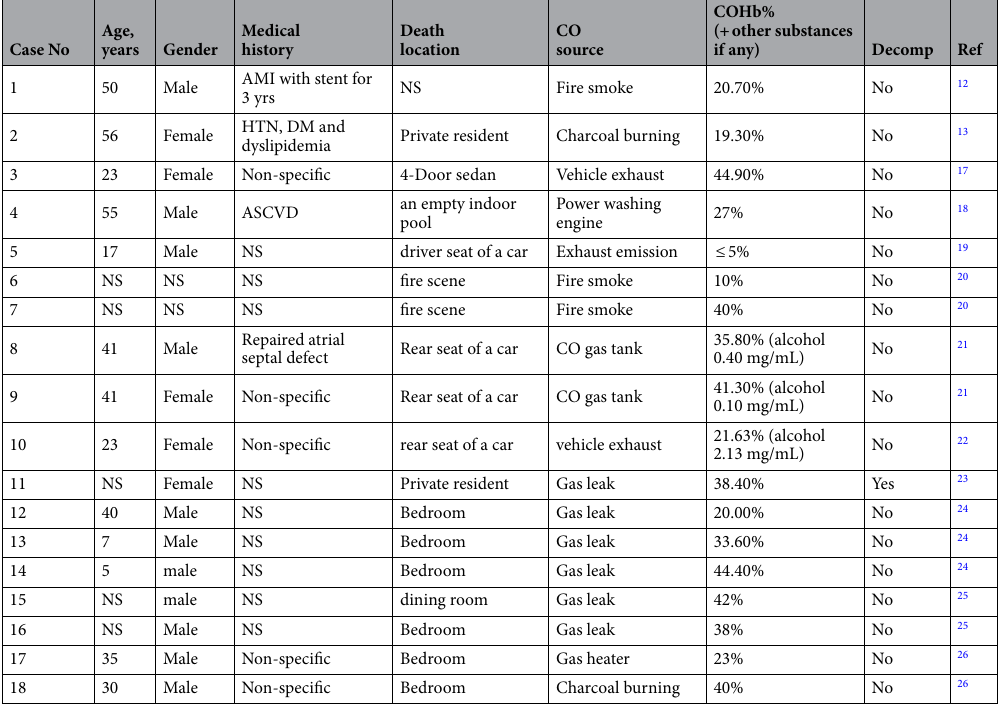
Table 1. A selected summary of low COHb%-related CO poisoning in the case-report literatures. NS not specified, AMI acute myocardial infarction, HTN hypertension, DM diabetes mellitus, ASCVD atherosclerotic cardiovascular disease, Decomp.